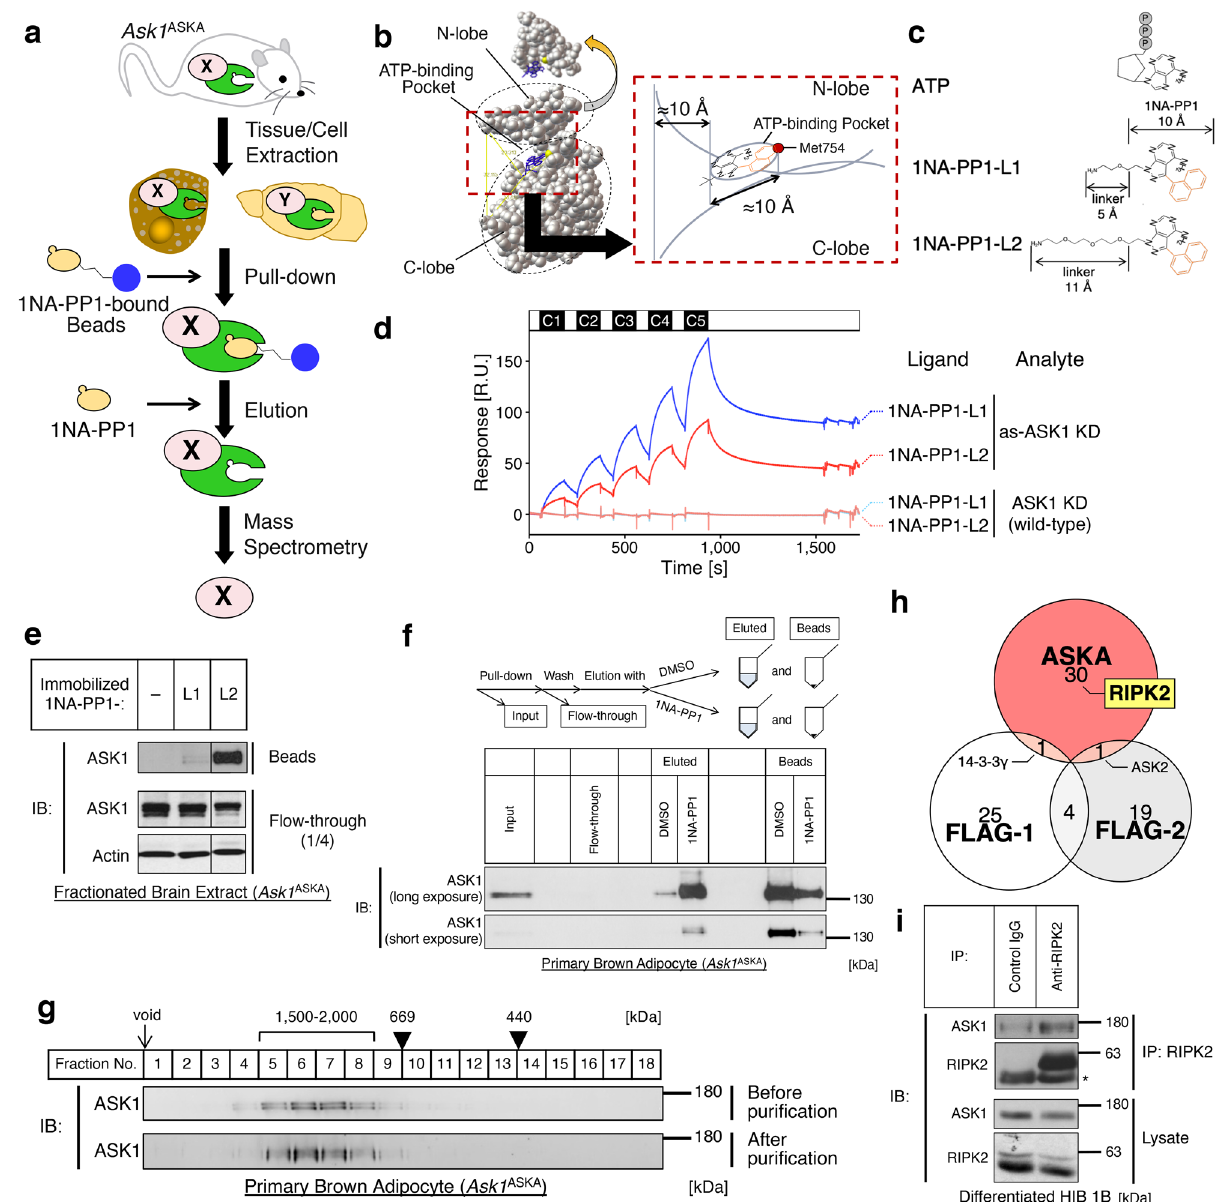
Figure 1. The ASKA technology-based pull-down MS method identified RIPK2 as an interactor of ASK1. ( a ) Overview of the ASKA pull-down MS method. The endogenous as-kinase signalosome was pulled down by incubating tissue/cell extracts from ASKA knock-in mice with 1NA-PP1-bound carrier beads, eluted by adding excess free 1NA-PP1, and subjected to mass spectrometry analysis. X and Y indicate unidentified components of the signalosome. ( b ) ATP-binding pocket of the ASK1 kinase domain (PDB: 2CLQ) 24 . ( c ) Chemical structures of 1NA-PP1 derivatives (1NA-PP1-Lx, x ∈ {1, 2}). 1NA-PP1 a bulky analog of ATP. ( d ) Binding affinity between the as-ASK1 kinase domain (KD) and 1NA-PP1-Lx. Setting 1NA-PP1-Lx as the ligand, the surface plasmon resonance signal was measured under a series of concentrations of the ASK1 KD analytes (white rectangle period: buffer, black rectangle period C1: 0.04 µM, C2: 0.06 µM, C3: 0.09 µM, C4: 0.13 µM, C5: 0.20 µM). R.U. resonance unit. ( e ) Pull-down ability of 1NA-PP1-Lx- immobilized beads for endogenous as-ASK1 in tissue lysate. Fractionated brain extracts from Ask1 ASKA knock-in mice were incubated with 1NA-PP1-Lx-immobilized beads, and the incubated beads and flow-through samples were subjected to immunoblotting (IB). Note that superfluous lanes were digitally eliminated from blot images as indicated by black lines and the uncropped images are presented in Supplementary Data. ( f ) Specific elution of as-ASK1 with 1NA-PP1. as-ASK1 was pulled down from the cell lysate of Ask1 ASKA knock-in mouse-derived primary brown adipocytes using 1NA-PP1-L2-immobilized beads and eluted with excess free 1NA- PP1. DMSO solvent of 1NA-PP1, a negative control. ( g ) Size of the as-ASK1 signalosome before and after purification. Cell lysates from primary brown adipocytes of Ask1 ASKA knock-in mice before and after purification with 1NA-PP1-L2-immobilized beads and 1NA- PP1 were fractionated with size exclusion chromatography. ( h ) Venn diagram of the ASK1 interactor candidates. ASKA ASKA pull- down MS for as-ASK1 derived from primary brown adipocytes in Ask1 ASKA knock-in mice, FLAG-1 Flag-tag pull-down MS for Flag- ASK1 derived from overexpressed HEK293A cells 27 , FLAG-2 Flag-tag pull-down MS for ASK1-HA-Flag derived from overexpressed HEK293 cells 28 . See Table 1 for each protein list. ( i ) Interaction between RIPK2 and ASK1 in a brown adipose cell line. Differentiated HIB 1B cells were processed for immunoprecipitation with anti-RIPK2 antibody. IP immunoprecipitation. *Immunoglobulin G heavy